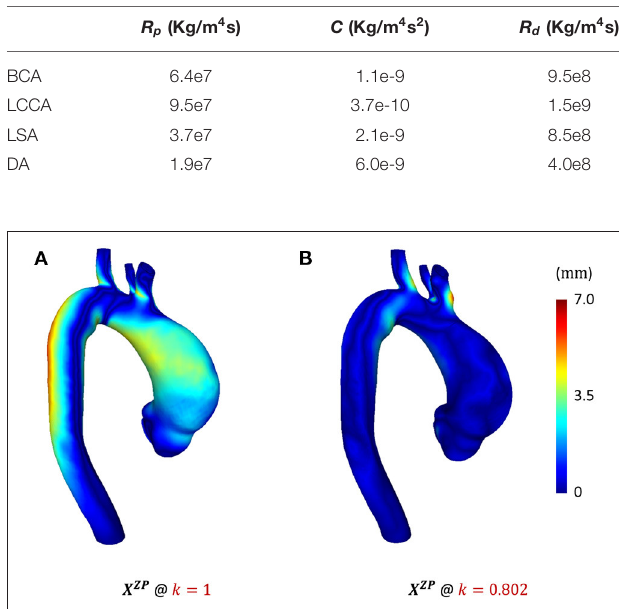
FIGURE 4 | Results in terms of distance from diastolic target geometry after pressurization of ZP configuration candidates: (A) k = 1 (initial guess) and (B) k =